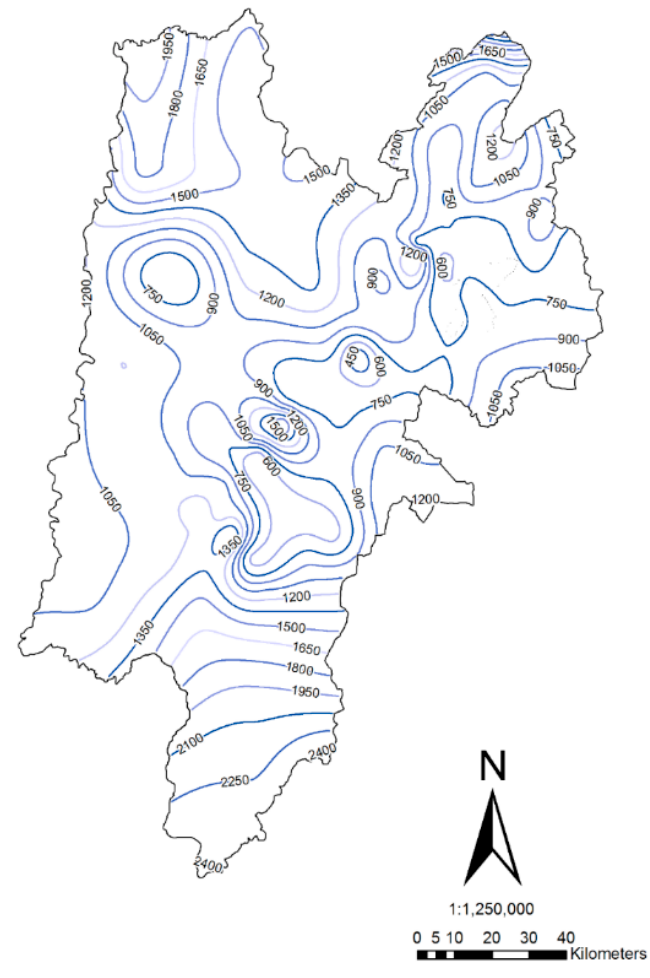
Figure 8. Map of isohyets for the study area in Cundinamarca, Colombia.